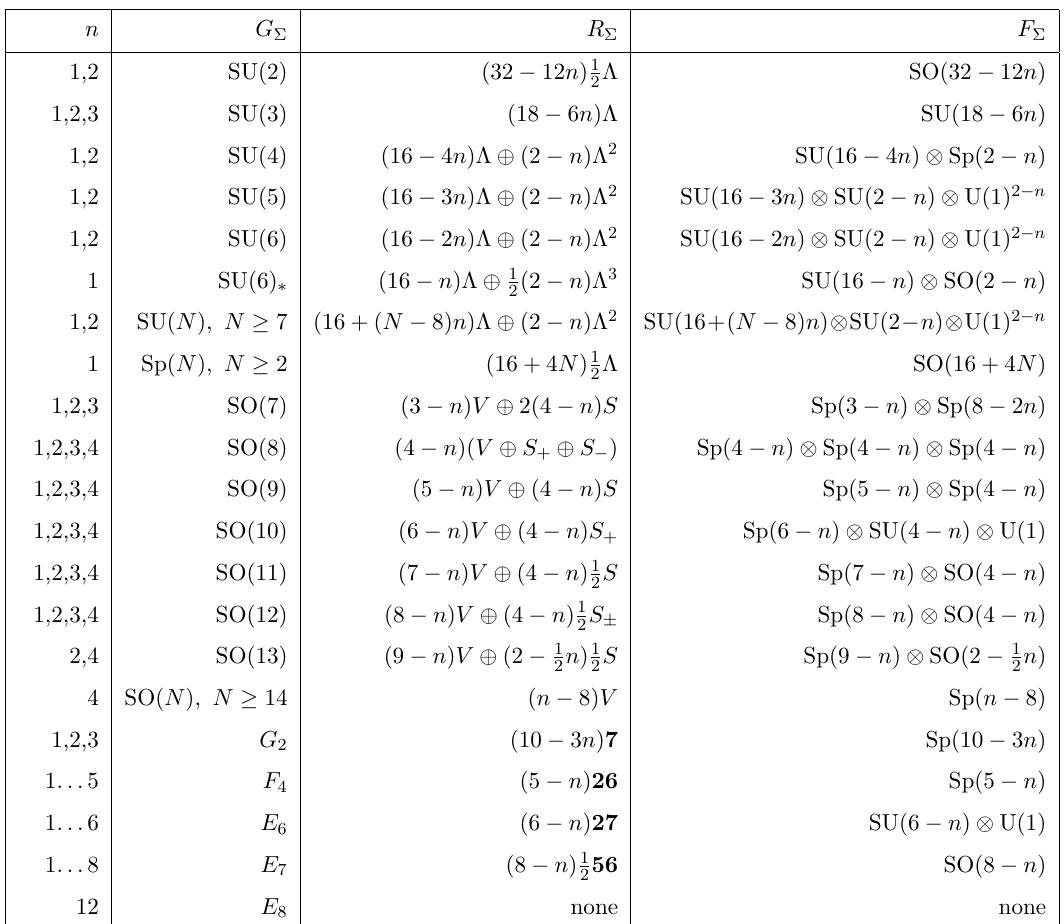
Table 6. Global symmetries and matter of rank one 6D SCFTs. For SU( N ) and Sp( N ), (cid:3) is the fundamental representation, and (cid:3) k its exterior powers. For SO( N ), V denotes the vector repre- sentation; for N odd, S denotes the spinor representation, while for N even we denote respectively by S + and S (cid:0) the spinor and conjugate spinor representations. Recall that k fundamentals in the SU( N ) case contribute a factor of SU( k ) to the (cid:13)avor symmetry group, instead of U( k ), see e.g. [73, 156]. There are two theories with G = SU(6); we use the terminology G = SU(6) (cid:3) to distinguish the one with F (cid:6) = SU(15) from the